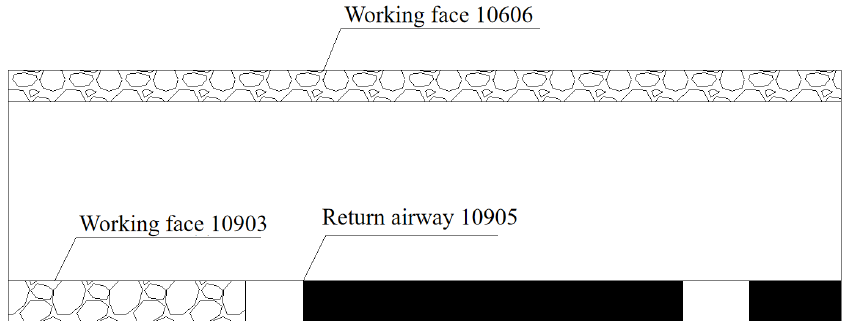
Figure 1. Arrangement of multi-working faces.